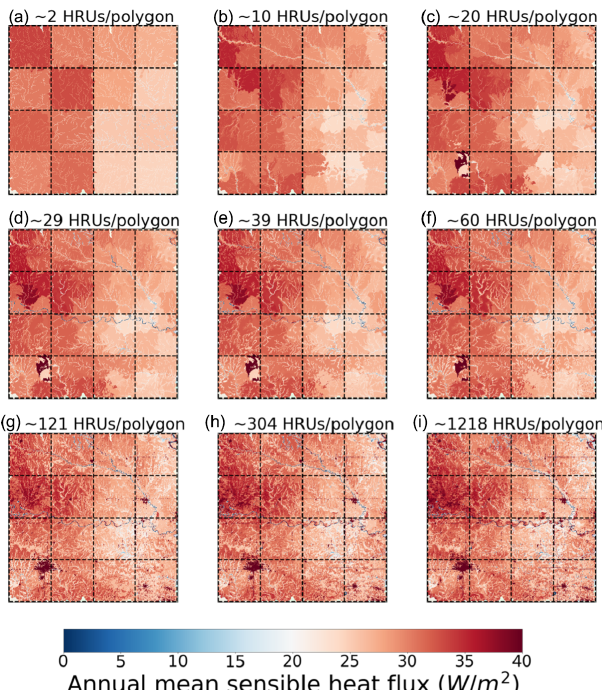
Figure 9. Simulated annual mean sensible heat flux over the 1.0 ◦ SGP domain. Each panel shows the mean sensible heat flux from the different HydroBlocks simulations. Each simulation was run with different configurations of the revised hierarchical clustering algorithm. Simulations (a) – (c) increase k from 1 to 5 to 10, while setting p = 1 and n = 1000; simulations (d) – (f) decrease n from 5 to 3 to 2, while setting p = 1 and k = 10; and simulations (g) – (i) increase the average number of intra-band clusters from 2 to 3 to 5, while setting n = 2 and p = 5. The average number of HRUs per macroscale polygon is shown as the title of each panel (the number can differ per macroscale